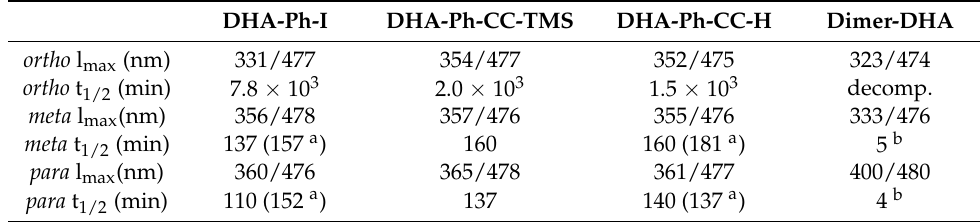
Table 1. Characteristic longest-wavelength absorptions l max (DHA value/VHF value) and half-lives of the thermal back-reaction VHF-to-DHA of ortho , meta and para analogues in MeCN extrapolated by Arrhenius plot at 25 ◦ C unless otherwise stated.